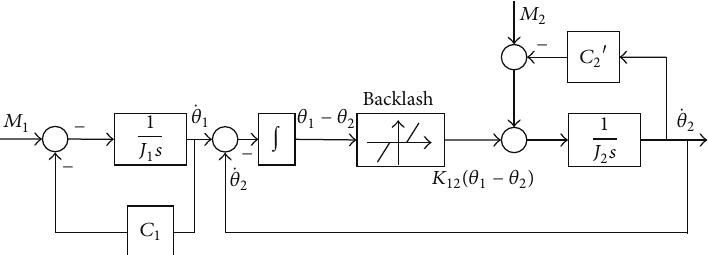
Figure 1: Structure of speed control model in main drive system with consideration of nonlinear influence.